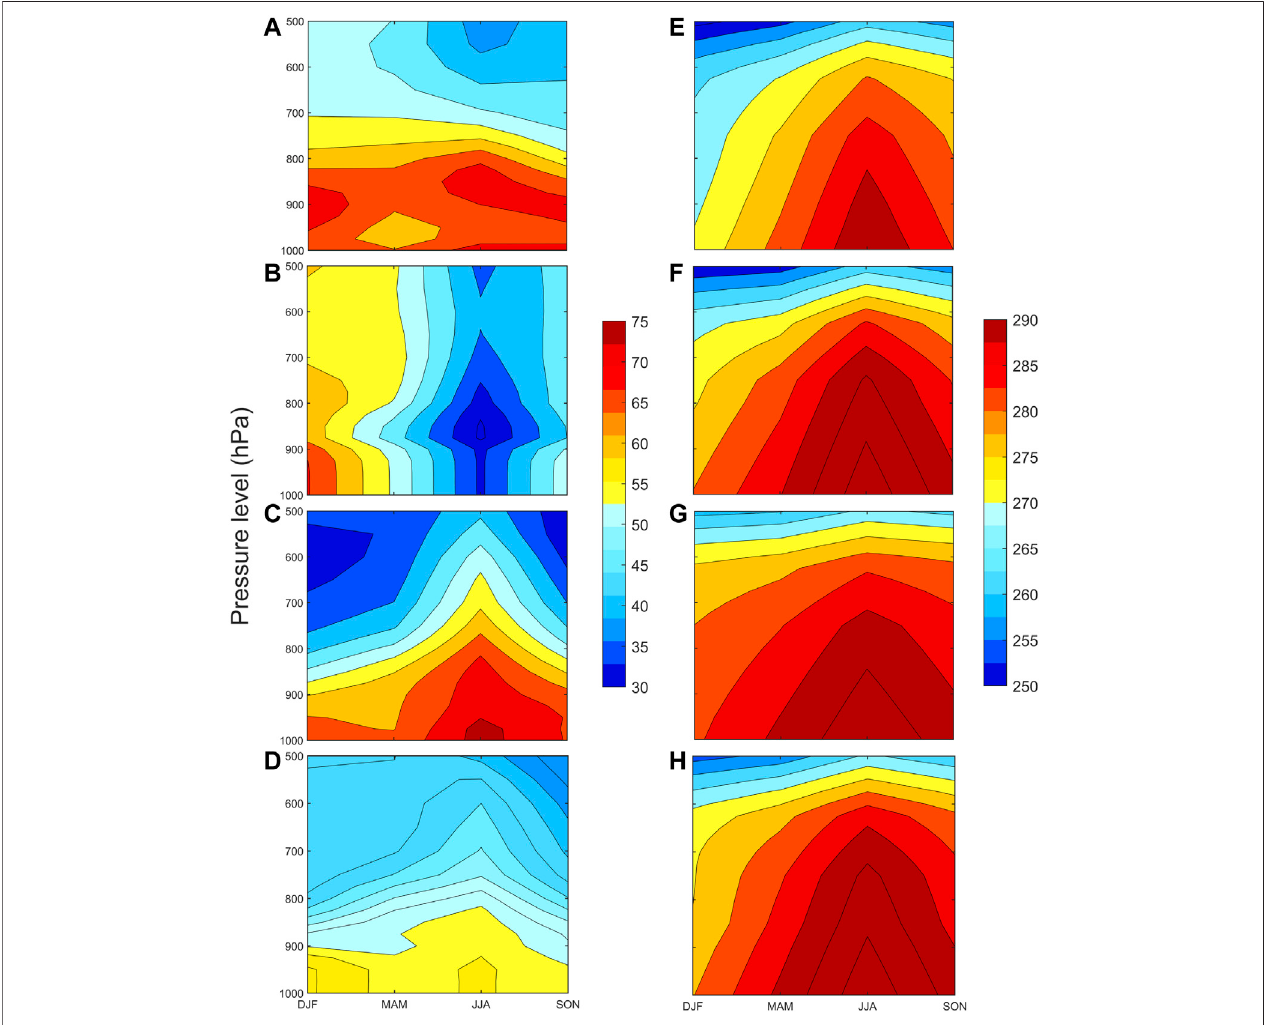
FIGURE 3 | Variation of relative humidity (A – D) (unit: %) and temperature (E – H) (unit: K) with altitude and seasons. (A) (E) Situation in Albany. (B) (F) Situation in Boise. (C) (G) Situation in Charleston. (D) (H) Situation in Dodge City.